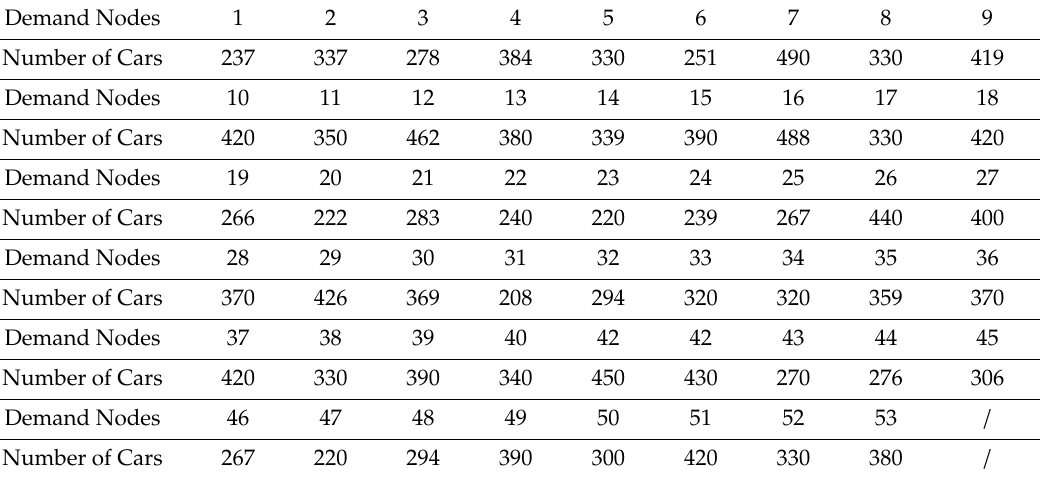
Table 2. The number of cars at each demand